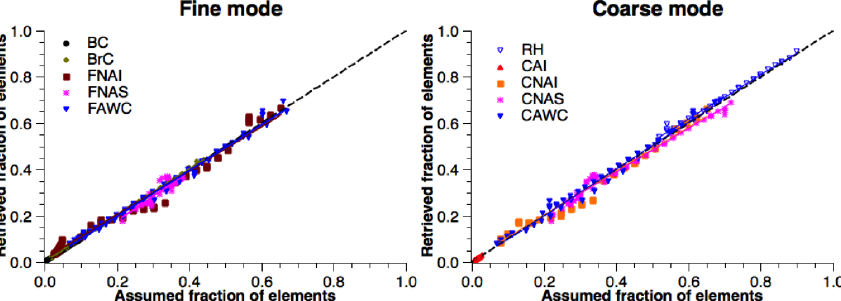
Figure 4. Assumed and retrieved fractions of aerosol species resulting from the sensitivity tests of the GRASP/Component retrieval using the Maxwell Garnett mixing